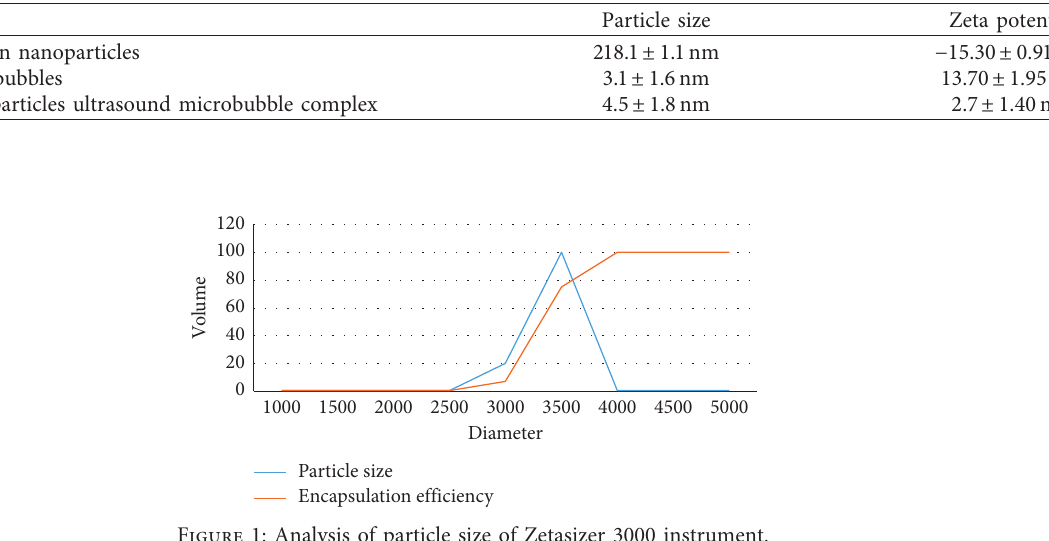
Table 1: Particle size and zeta potential.